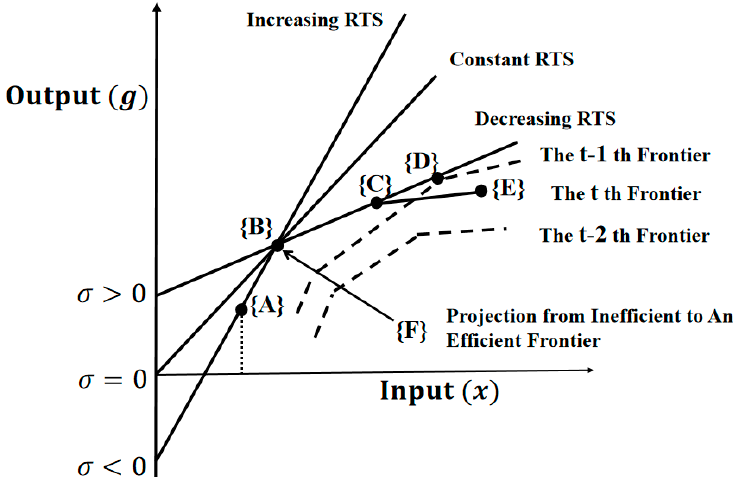
Figure 1. Three types of RTS and supporting hyperplanes. Note: (a) We classify the types of RTS into three cases: increasing, constant or decreasing. (b) Since the efficiency frontier {A-B-C-E} is determined by the best DMU group in multiple periods ( t = 1, ..., T ). The figure exhibits, for example, the three periods { t − 2, t − 1 and t ). The frontier may contain a group of DMUs among different periods. For example, there is the crossover between the t − 1 and t th frontiers so that the frontier becomes {A-B-C-E}. (c) The location of a supporting hyperplane is determined by the sign of the intercept ( σ ). (d) DMU {D} locates the frontier of the t − 1 period. But, it is not on the frontier during the three periods because of the overlap between the t and t − 1th periods. The type of inefficient DMU {F} needs to be projected onto DMU {B} and the type is determined on {B} on the frontier.